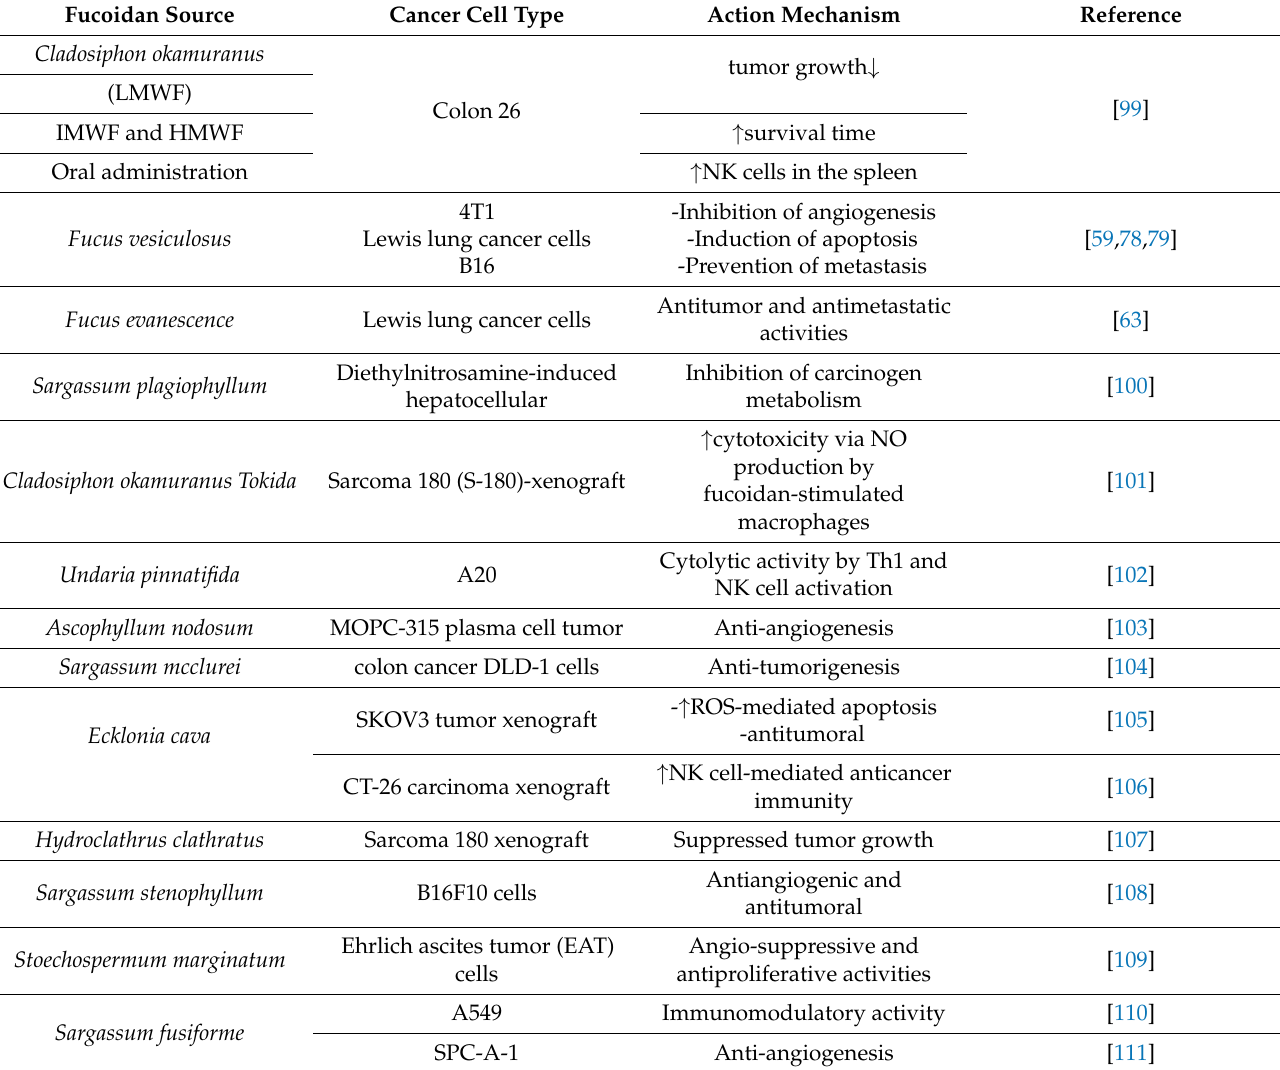
Table 2. In-vivo effect of fucoidan on tumor growth in tumor-bearing